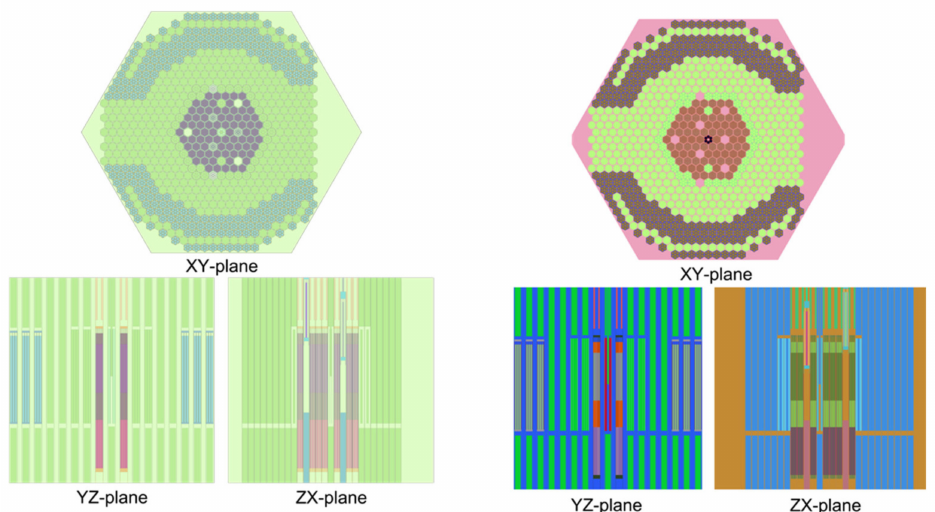
Figure 1. Cross-sectional views of 3D CEFR core of Serpent 2 ( left ) and OpenMC ( right ). XY-plane at the center view shows 79 fuel subassemblies surrounded by SS reflectors and B 4 C shielding. The boundary condition is given as void; thus, Serpent represents void boundary condition in black color. YZ and ZX planes at the center show axial configuration. All subassemblies have SS reflector at the bottom region.